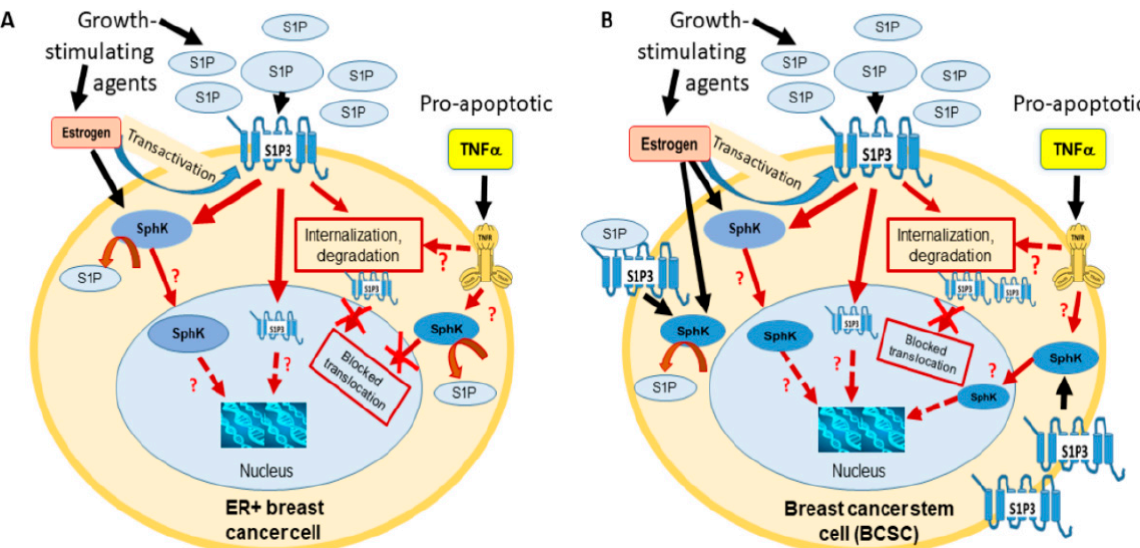
Figure 7. Schematic presentation of SphK1 and S1P3 trafficking in parental MCF-7 cells ( A ) and MCF-7 derived BCSC- enriched mammospheres ( B ). Increased S1P3 expression and transformed TNF α signaling was detected in BCSC-enriched mammospheres ( B